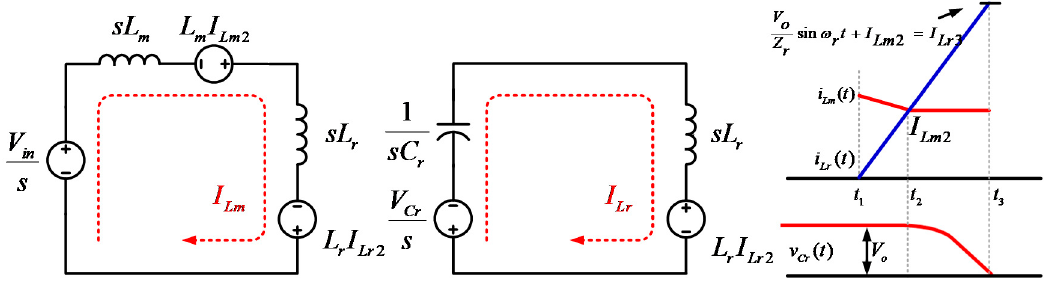
Figure 5. The equivalent circuit of Mode 2 and key waveform.